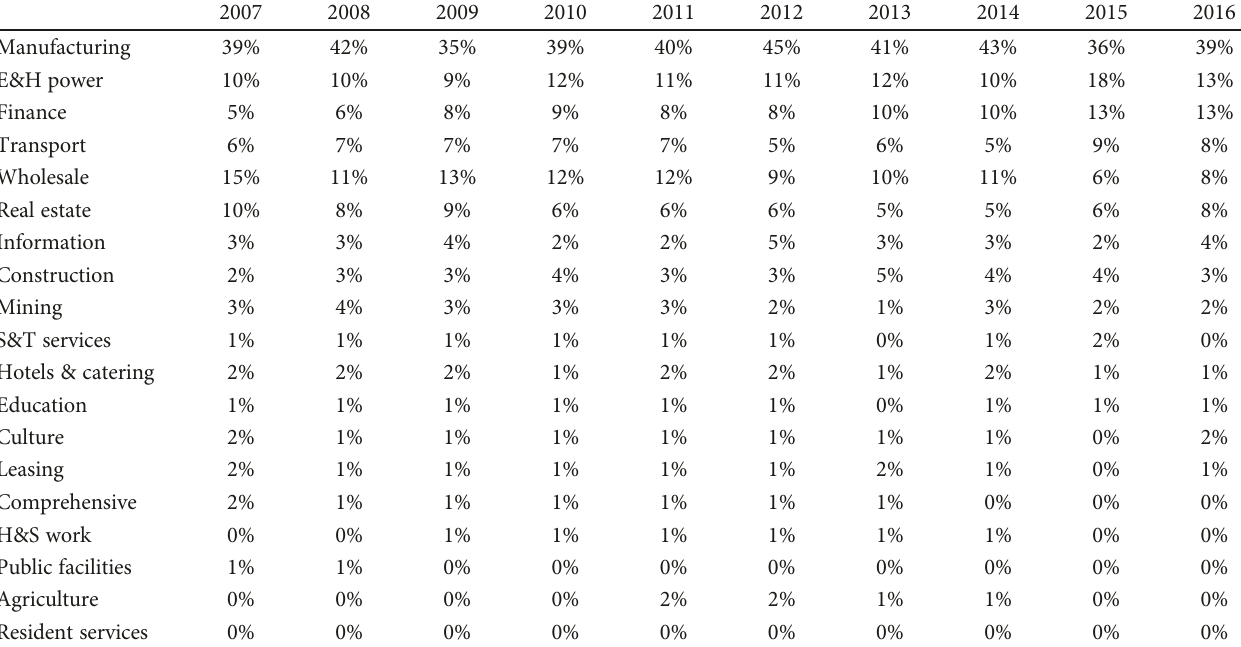
Table 2: Annual distribution of industry sectors in the triadic motifs of the